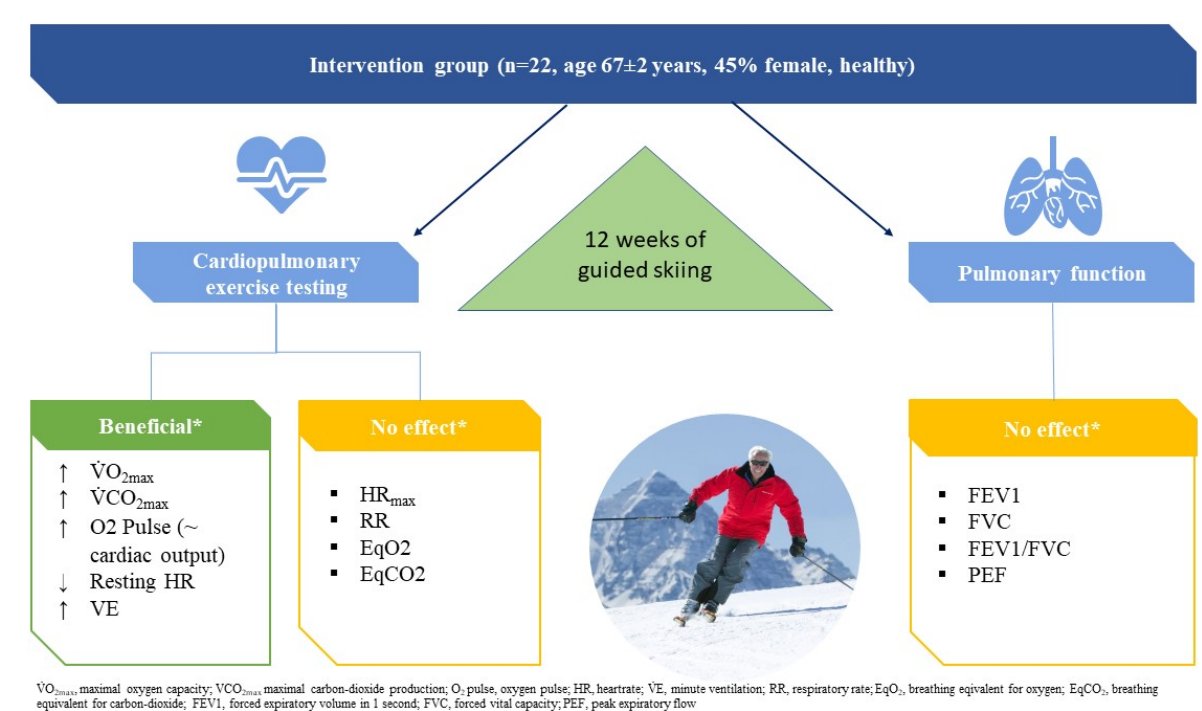
Figure 1. Graphical abstract summarizing the findings of this study. Table 2. CPET-results at REST, AT, and MAX in PRE–POST